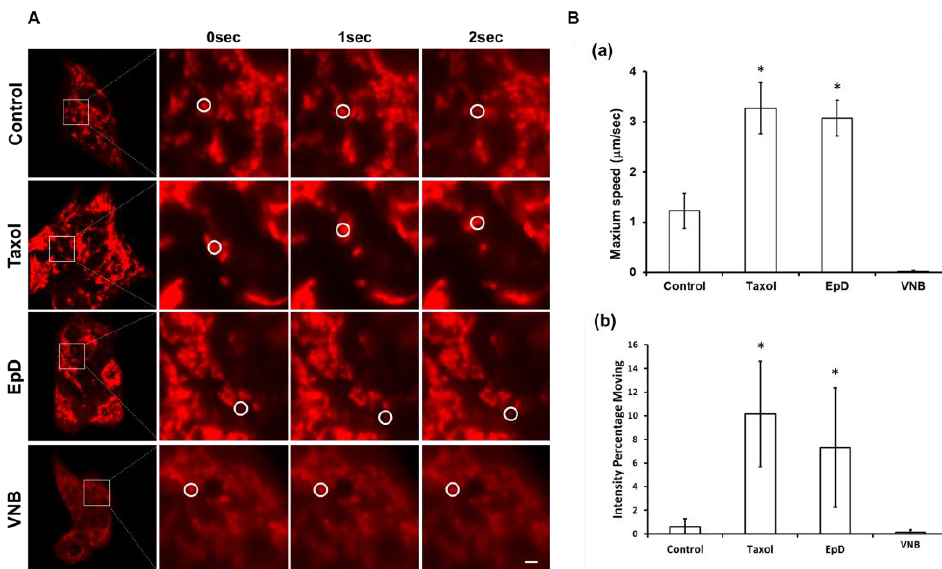
Figure 4. Confocal live-cell imaging to the tracking of mitochondria movement in microtubule stabilizer- and microtubule disturb- er-treated cells. ( A ) Confocal live-cell imaging of control, Taxol-treated, EpD-treated, and VNB-treated cells. White circles indicate the localization of mitochondria. Scar bar = 2 μ M. ( B ) Graphs of the ( a ) maximum speed of mitochondria and ( b ) percentage of moving mitochondria in control, Taxol-treated, EpD-treated, and VNB-treated cells. Data are presented as means ± SEM of three replicates. Significant differences are indicated by asterisks (* p < 0.05).